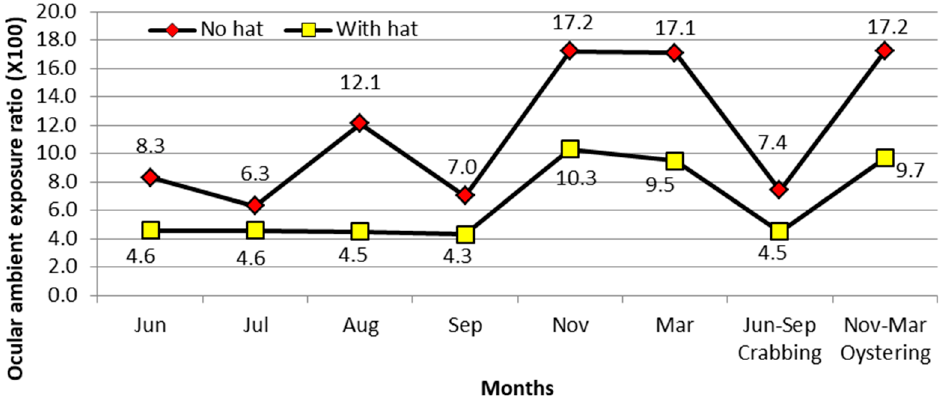
Figure 7. Ocular UV measurements without hats (mean = 11.2 ± 8.5, n = 28) and with hats. (mean = 7.2 ± 7.1, n = 148) [55].